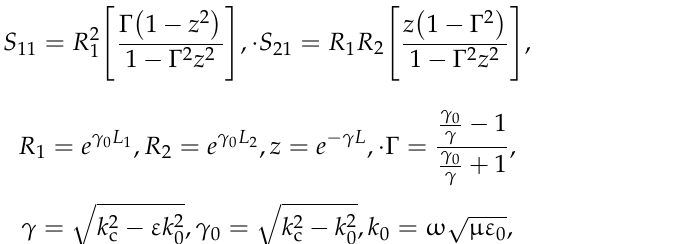
Figure 13. Measuring unit: 1, Section of a detachable waveguide path; 2, test sample. Dielectric constants were determined by the method of reflection–transmission energy coefficients, measuring reflection coefficients (parameter S 11 ) and transmission (parameter S 21 ) of the electromagnetic energy of microwave